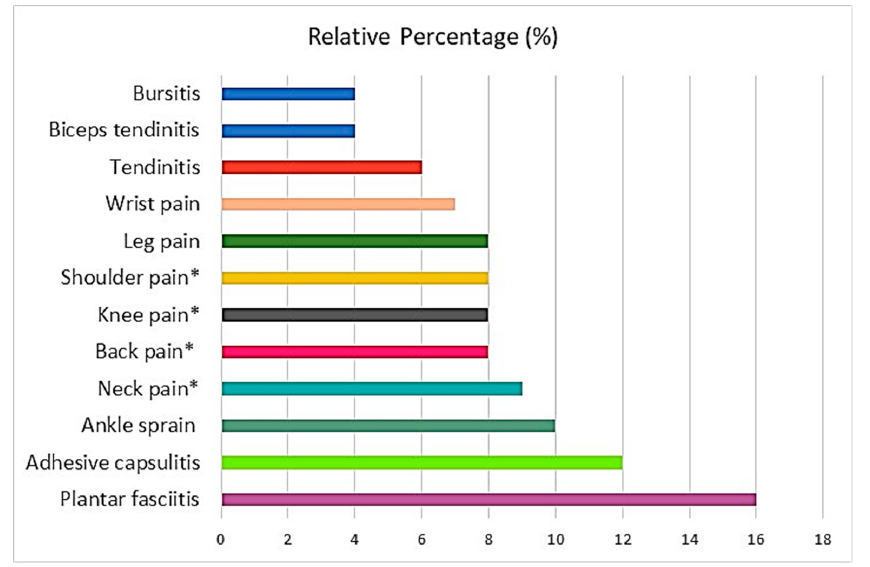
Figure 2. Incidence (%) of patients with sport-related injuries (N = 200) before treatment (which were then subsequently treated). * Means pain in muscles and soft tissues.